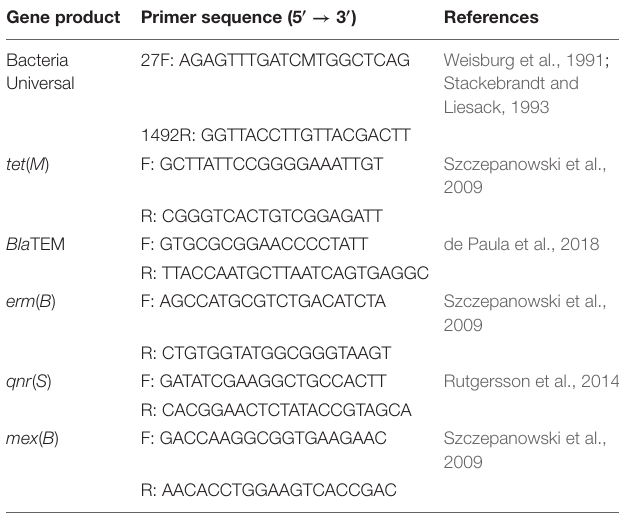
TABLE 1 | Reverse and forward primers for the amplification of the 16S rRNA gene and a selection of representative antibiotic resistance genes used in this study.